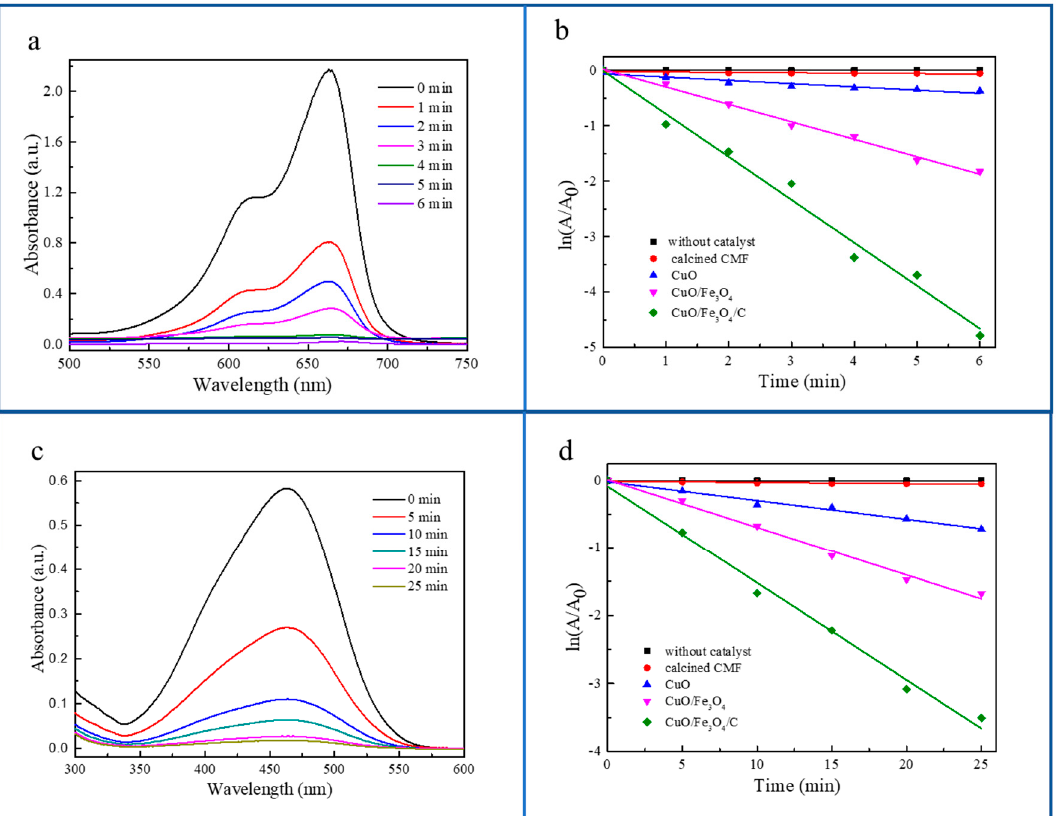
Figure 5. ( a ) Time-dependent UV–Vis absorption spectra of methylene blue (MB) with the carbon-doped CuO/Fe 3 O 4 composite catalyst in the presence of NaBH 4 ; ( b ) the corresponding first-order kinetic plot (absorbance at 660 nm, ln(A t /A 0 )) versus reaction time for the reduction of MB; A t and A 0 represent the absorbance of MB (660 nm) at designated time t and t = 0, respectively; ( c ) time-dependent UV–Vis absorption spectra of methyl orange (MO) with the carbon-doped CuO/Fe 3 O 4 composite catalyst in the presence of NaBH 4 ; ( d ) the corresponding first-order kinetic plot (absorbance at 460 nm, ln(A t /A 0 )) versus reaction time for the reduction of MO; A t and A 0 represent the absorbance of MO (460 nm) at designated time t and t = 0, respectively.